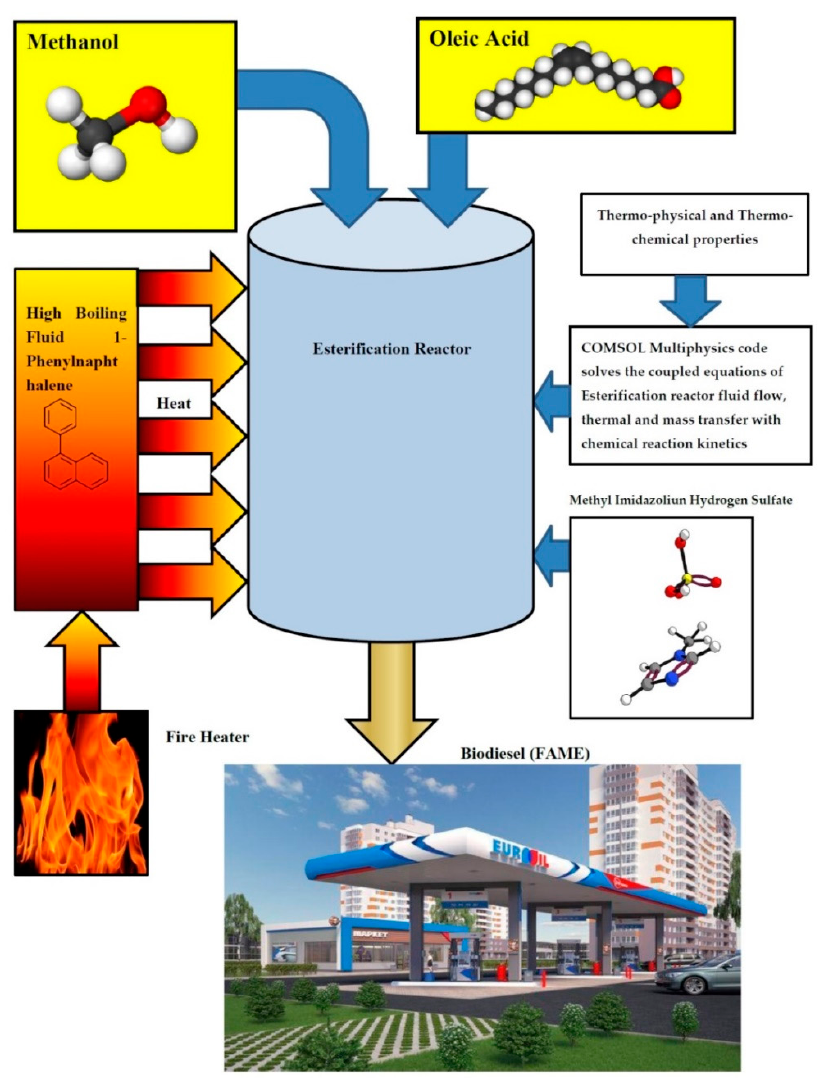
Figure 2. Schematics of the proposed esterification reactor of oleic acid and methanol to FAME.